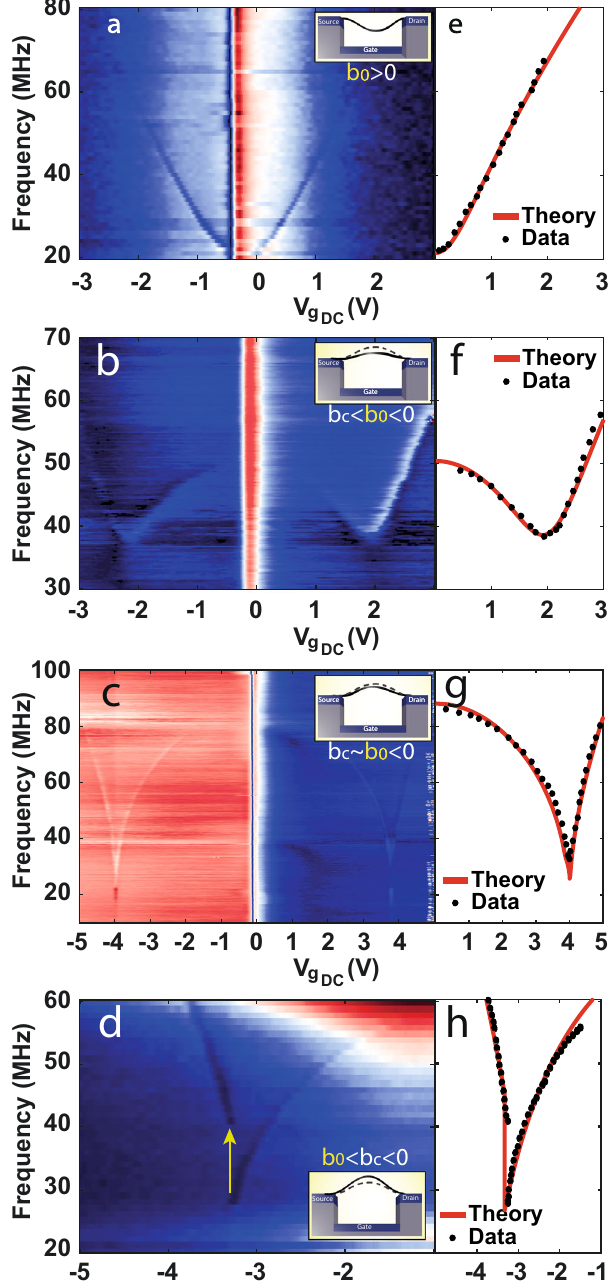
Fig.2|In fl uenceofinitialbucklingonthedynamicresponse.a – d Representative resonance frequency measurements of devices III-VI for the different categories, where a b 0 >0, b b c ≪ b 0 <0, c b c ≤ b 0 <0, and d b 0 <b c <0. The insets are sche- matics of the initial shape of the CNT (solid arch), illustrating the different classes relative to the critical value b c (dashed arch). e – h Modeling the dynamic response of the same devices in ( a – d ),respectively. The solid lines are the theoretical fi tting totheexperimentaldata(blackdots).TheinitialCNTheightsextractedfromthe fi t are e b 0 =10nmfordeviceIII, f b 0 = − 6nmfordeviceIV, g b 0 = − 38nmfordeviceV, and h b 0 = − 45nm for device VI, in agreement with our qualitative